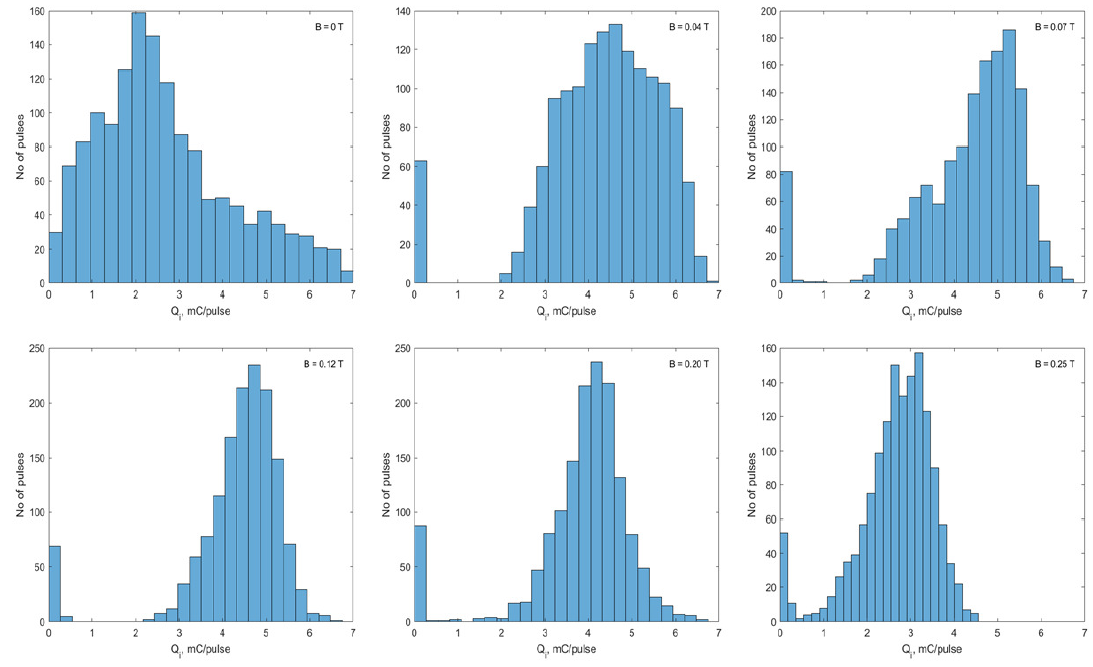
Figure 9. Charge per pulse Q i statistics over a firing cycle measured at different magnetic